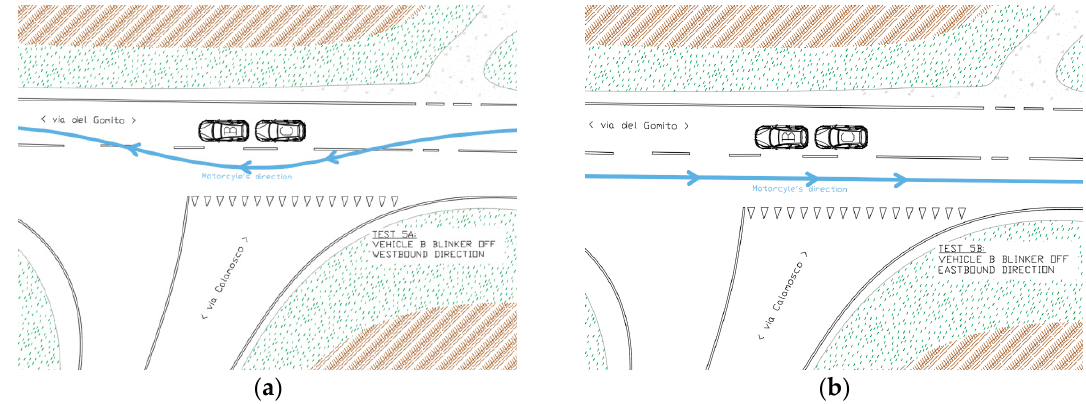
Figure 7. Simulation 5( a ) overtaking, and 5( b ) going through, schemes.